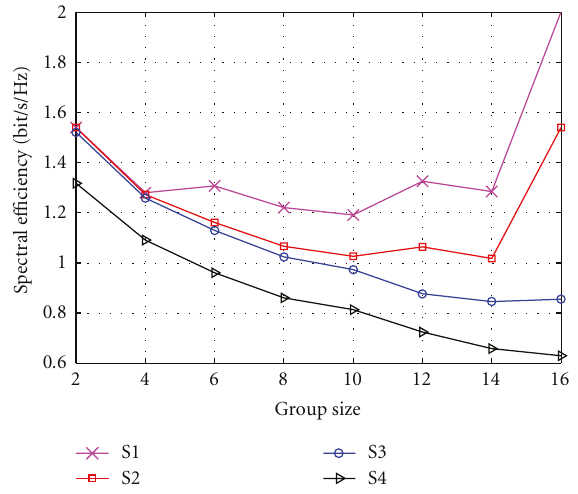
Figure 6: Overall spectral e ffi ciency of ARQ-AMC schemes versus group